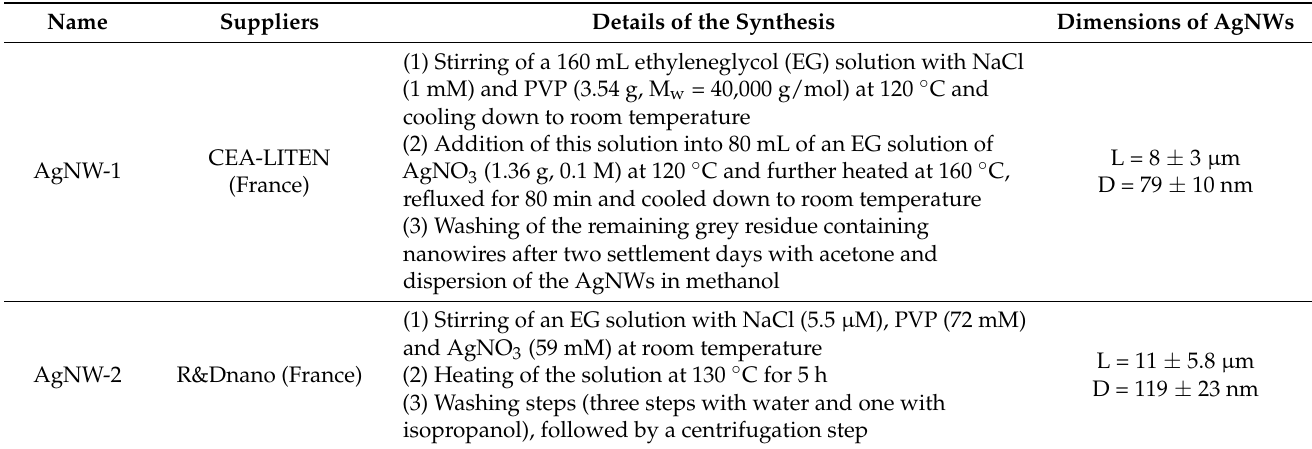
Table 1. Synthesis conditions and dimensions (Length, L, and Diameter, D) of two types of